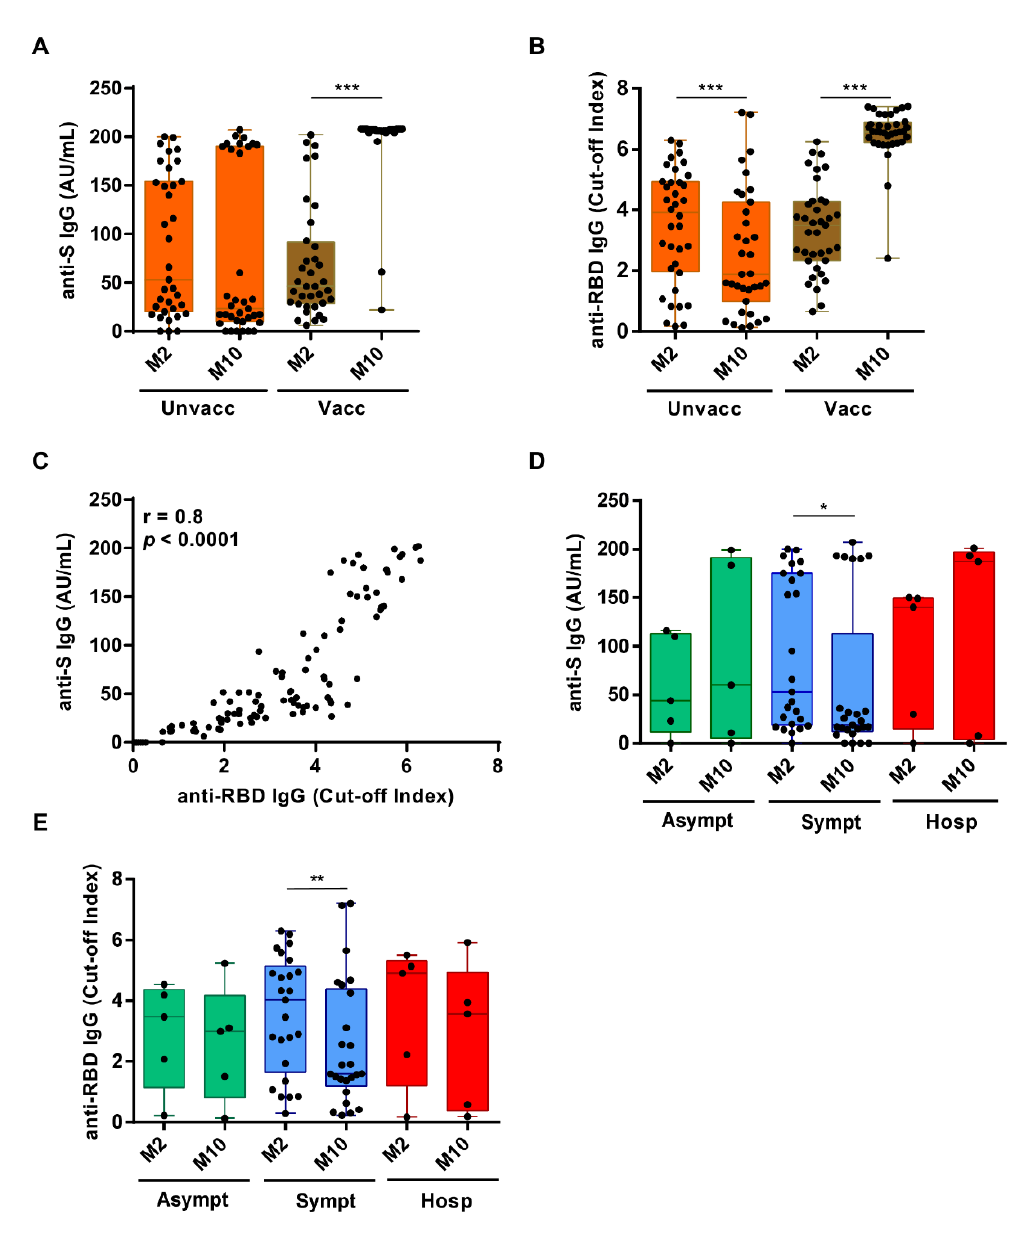
Figure 3. Dynamic changes in anti-S and anti-RBD IgG levels between M2 and M10 after the first PCR-positive test. ( A ) Box plot distribution of anti-S IgG levels or ( B ) anti-RBD IgG levels in unvaccinated (left) or vaccinated (right) subjects at M2 vs. M10. Solid circles indicate individual values. p -values were calculated by two-sided Wilcoxon signed-rank tests. *** p < 0.001. ( C ) Spearman correlation between anti-S IgG AU/mL and anti-RBD IgG cut-off index as assessed by ELISA at M10. ( D ) Comparison of anti-S IgG levels between asymptomatic (n = 16), symptomatic (n = 74), or hospitalized (n = 10) subjects at M2 and M10. p -values were calculated by two-sided Wilcoxon signed-rank tests. * p < 0.05. ( E ) Comparison of anti-RBD cut-off index between asymptomatic n = 16, symptomatic n = 74, or hospitalized n = 10 subjects at M2 or M10. p -values were calculated by two-sided Wilcoxon signed-rank test. ** p < 0.01.